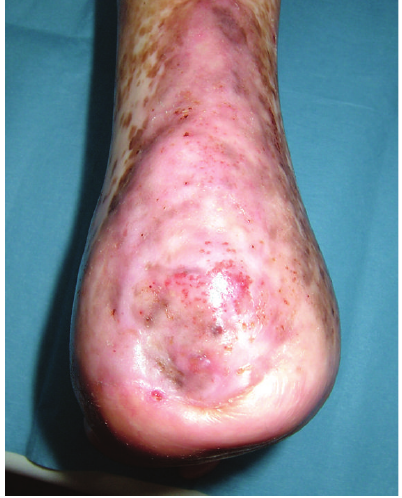
Figure 7: One year after operation, no recurrence of ulcers and